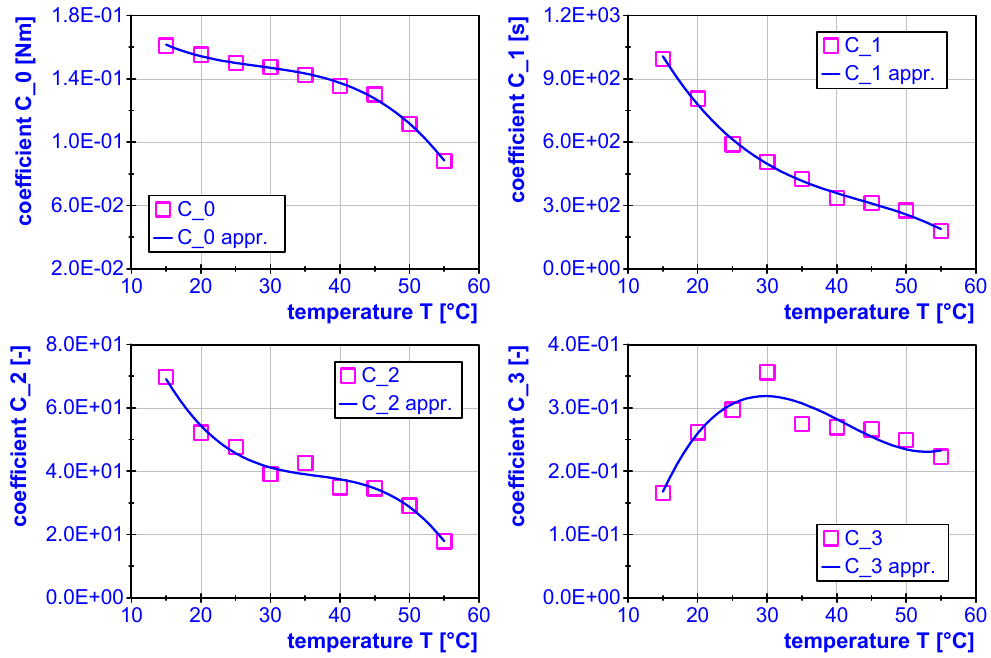
Figure 4. Visualization of approximation of coefficients C i , describing the curing behavior of adhesive SikaFast 5215 NT.